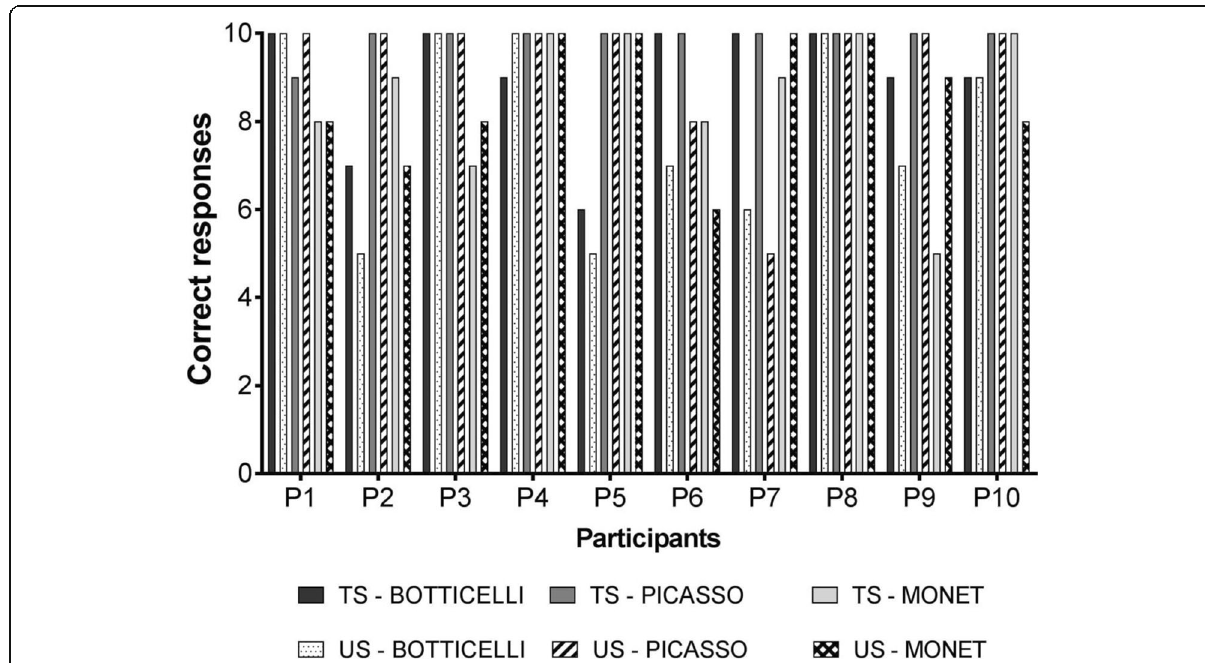
Fig. 3 The bars represent the number of correct responses regarding the relations that were performed by the participants on the presented trials in phase 6 that contain the test of relations TC/PC/MC. TS (trained stimuli) 6 to 10 and US (untrained stimuli) 11 to 15 were used as sample